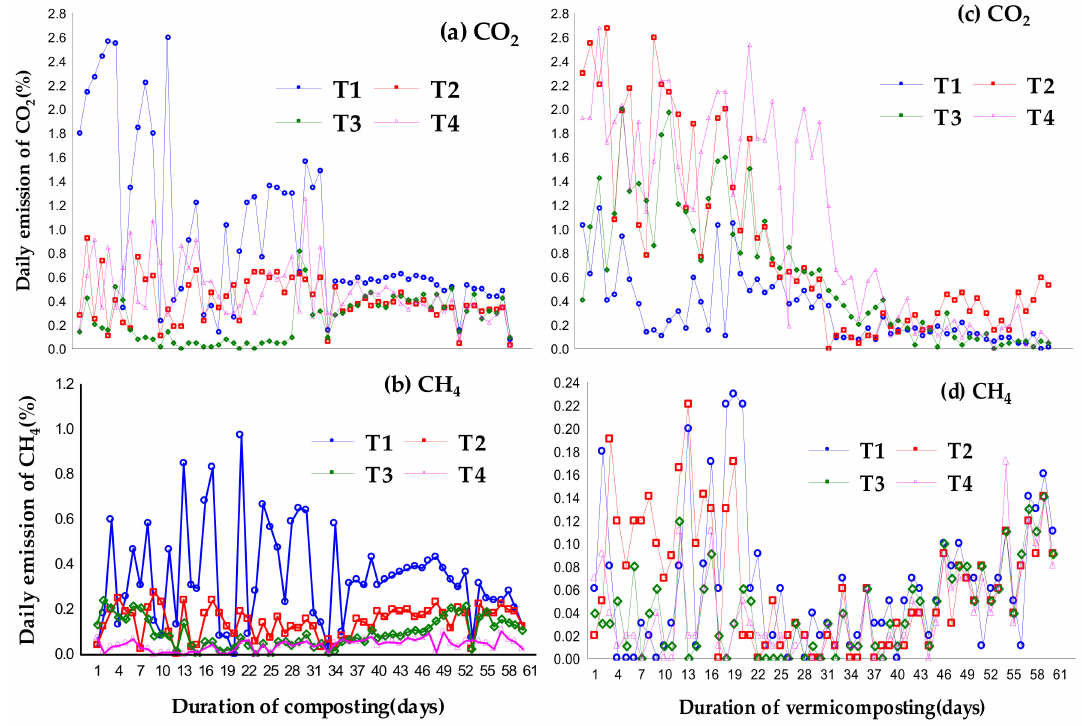
Figure 2. Daily emissions of CO 2 and CH 4 during composting ( a,b ) and vermicomposting ( c,d